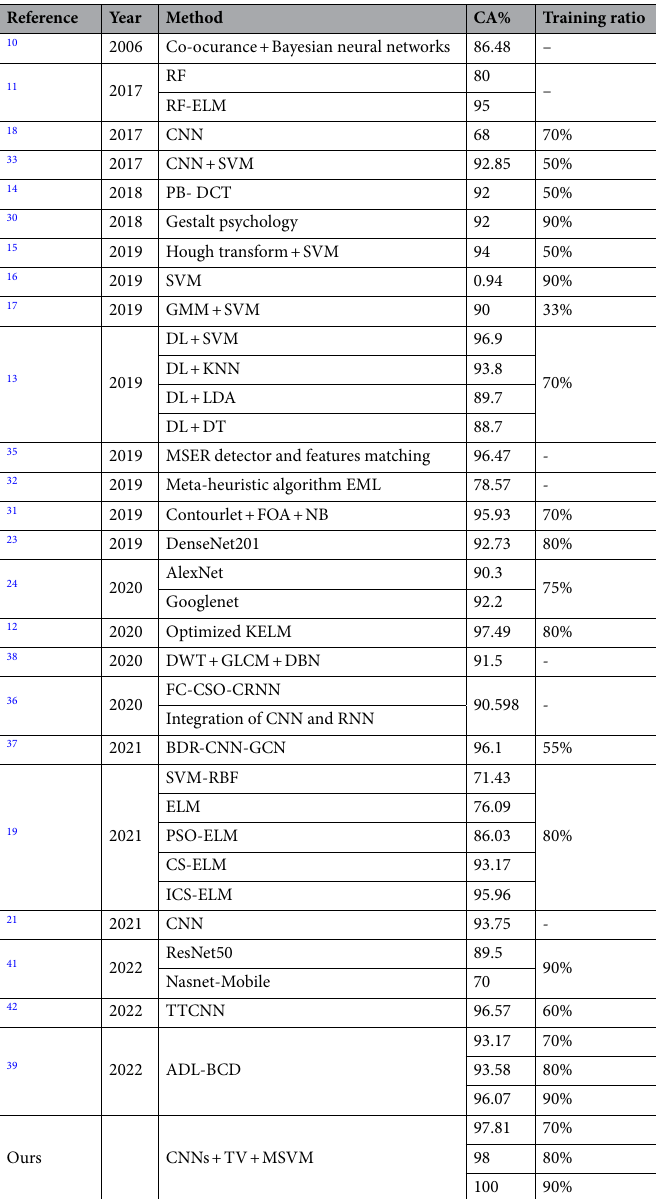
Table 8. The CA % of the proposed method and other existing